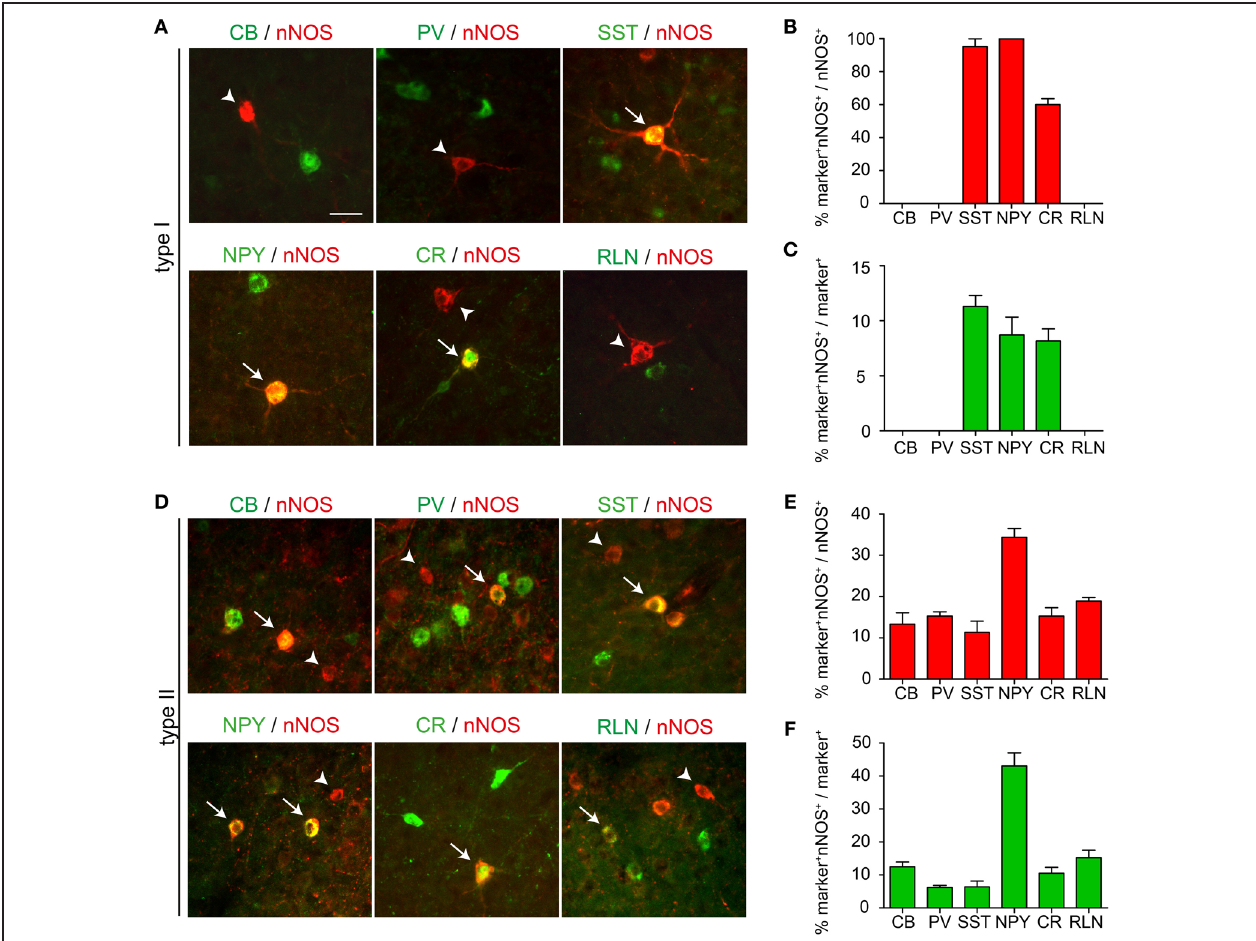
FIGURE 4 | Coexpression of nNOS with other interneuron markers. (A) Expression of CB, PV, SST, NPY, CR, or RLN in nNOS type I cells. (B) Quantification of the extent of coexpression between nNOS and the different interneuron markers in type I cells. (C) The number of marker + nNOS type I cells is presented as a percentage of the total number of